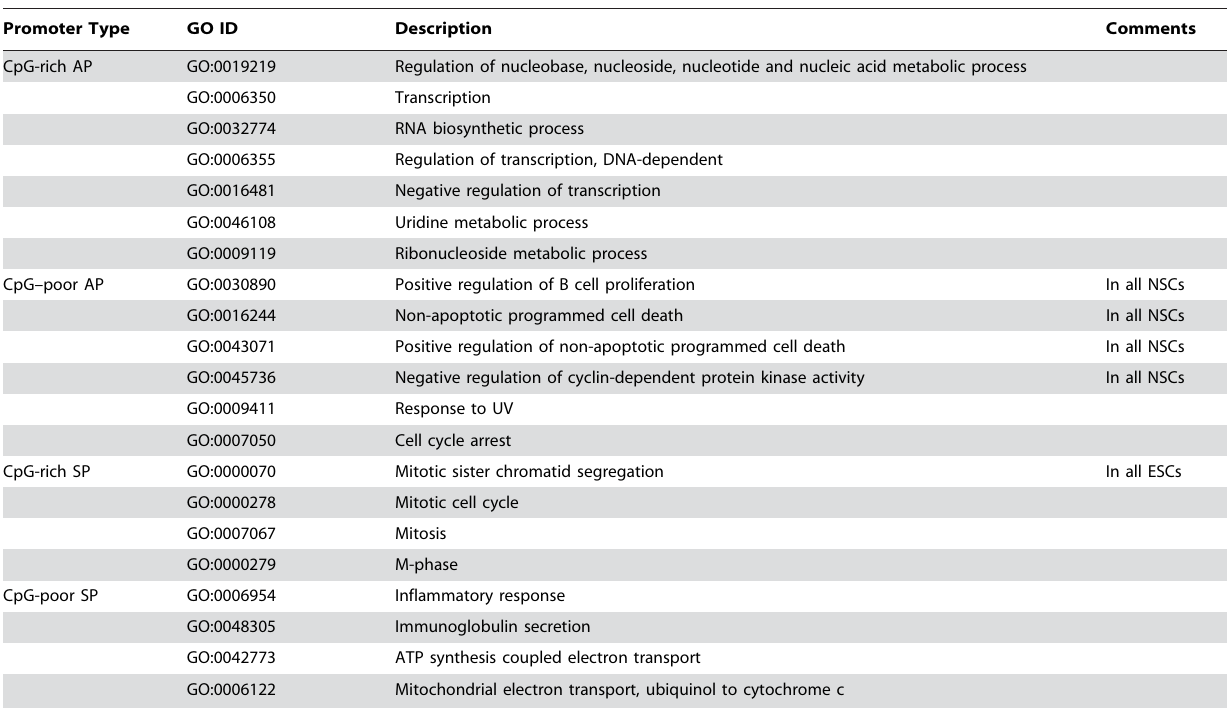
Table 13. Over-represented GO term identifiers in the four promoter categories.